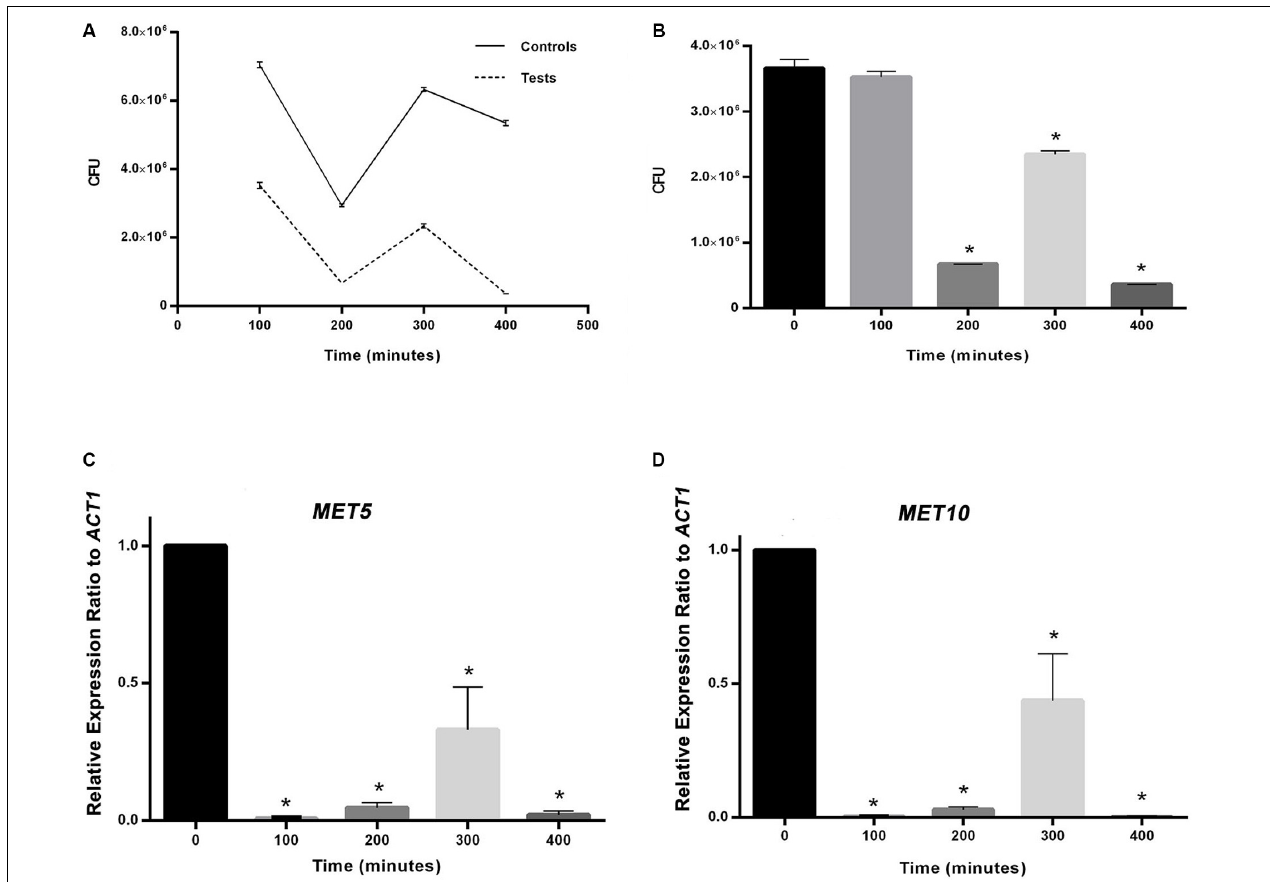
FIGURE 2 | (A) The effect of experimental conditions on S. cerevisiae population in comparison with the control. (B) Comparison between population of S. cerevisiae in time point zero and following time points. (C) and (D) Comparison between relative expression ratio of MET5 and MET10 genes to ACT1 in time point zero and following time points. Asterisks represent significant differences at p <